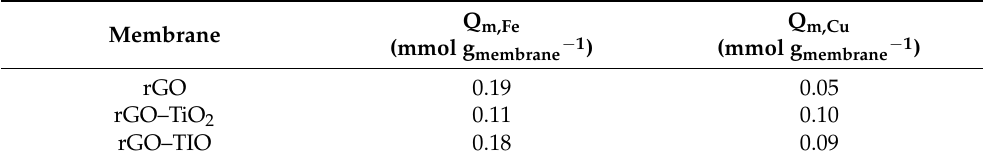
Table 3. Specific captured amounts of Fe 3+ or Cu 2+ ions as a function of membrane weight (Q m , Equation (1)).